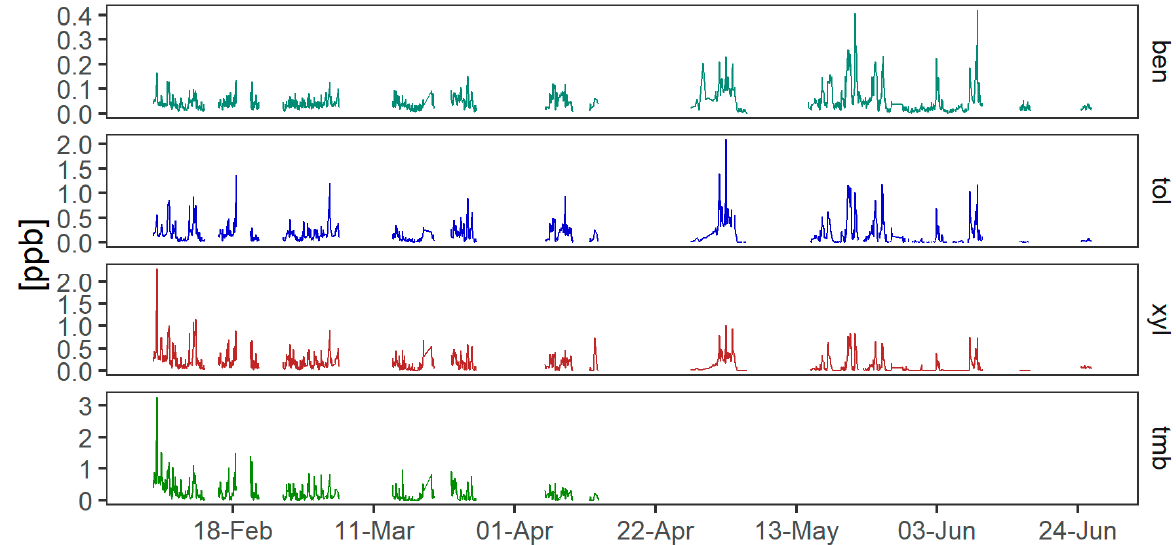
Figure 3. Timeseries of AVOCs measured at the ANSTO site using the BAASS. Ben = benzene, xyl = p-xylene, tol = toluene and tmb = 1-2-4-trimethyl-benzene. TMB concentrations were not recorded after mid-April due to an error in the GC-MS analysis method (see Supplementary Materials).